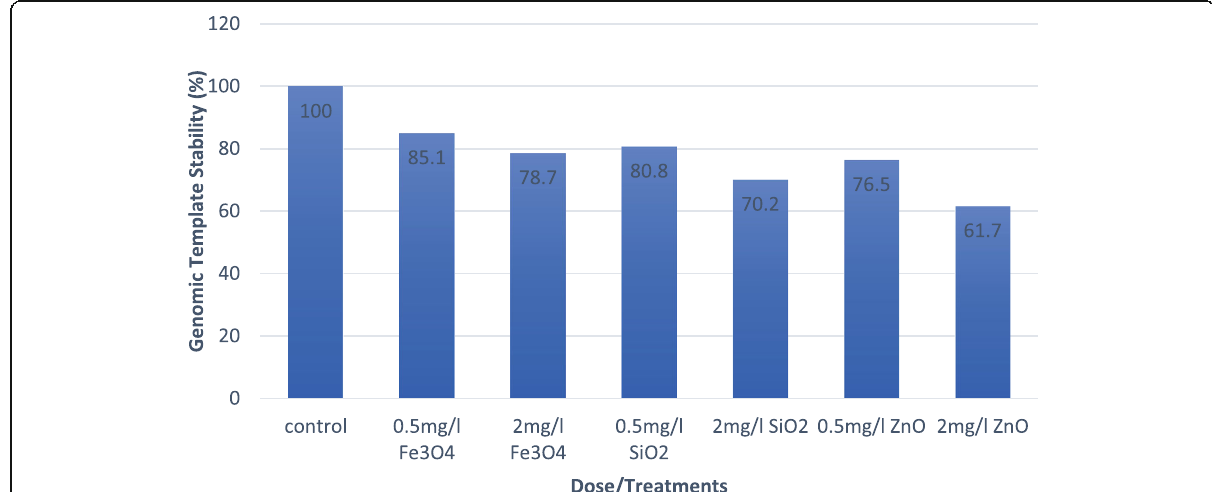
Fig. 5 Comparison of genomic DNA template stability (GTS) in 45-day-old callus treated with 0.5 and 2 mg/l of Fe 3 O 4 , SiO 2 , or ZnO nanoparticles and the control in Salvadora persica